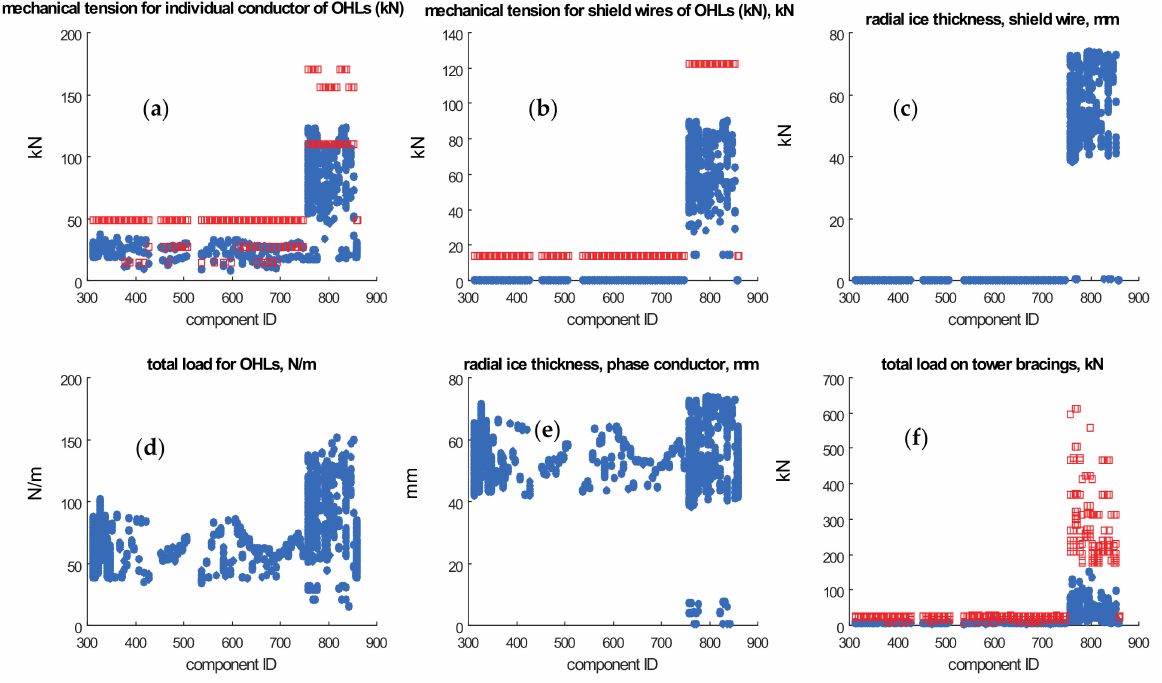
Figure 4. Mechanical tension on phase conductors ( a ) in kN, and on shield wires ( b ) in kN, wet snow sleeve thickness on shield wires ( c ), total load on OHL conductors ( d ), wet snow sleeve thickness on phase conductors ( e ), total load on tower supports ( f ). Red squares represent the maximum admissible stress on the subcomponents. Components with IDs between 300 and 750 represents MV lines while components with IDs between 750 and 820 represent HV (132 and 220 kV) line, case